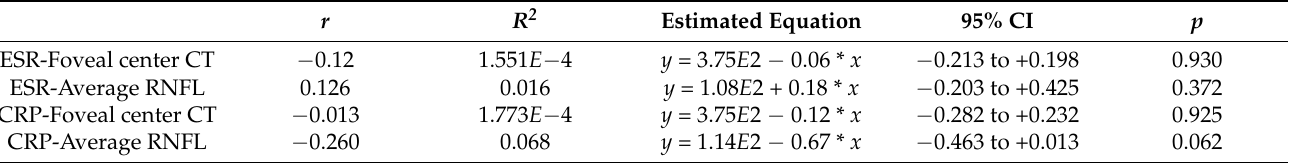
Table 4. Correlation between inflammation markers and choroidal and retinal fiber layer